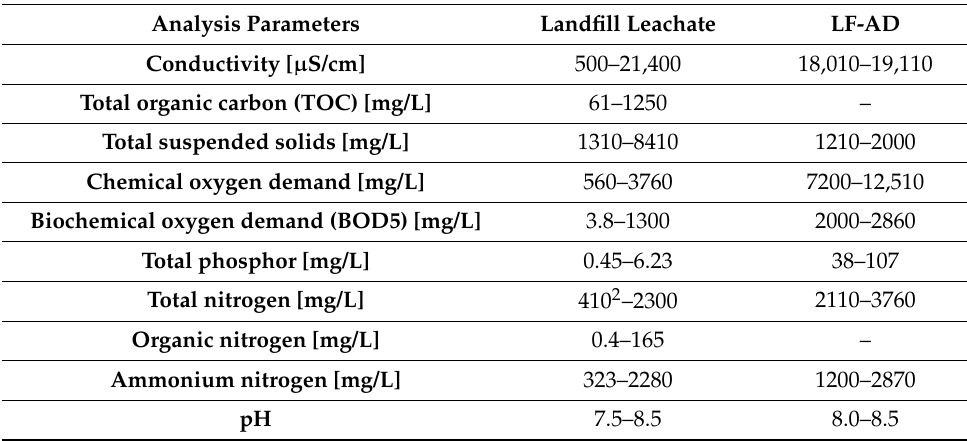
Table 1. Characteristics of the landfill leachate and LF-AD in